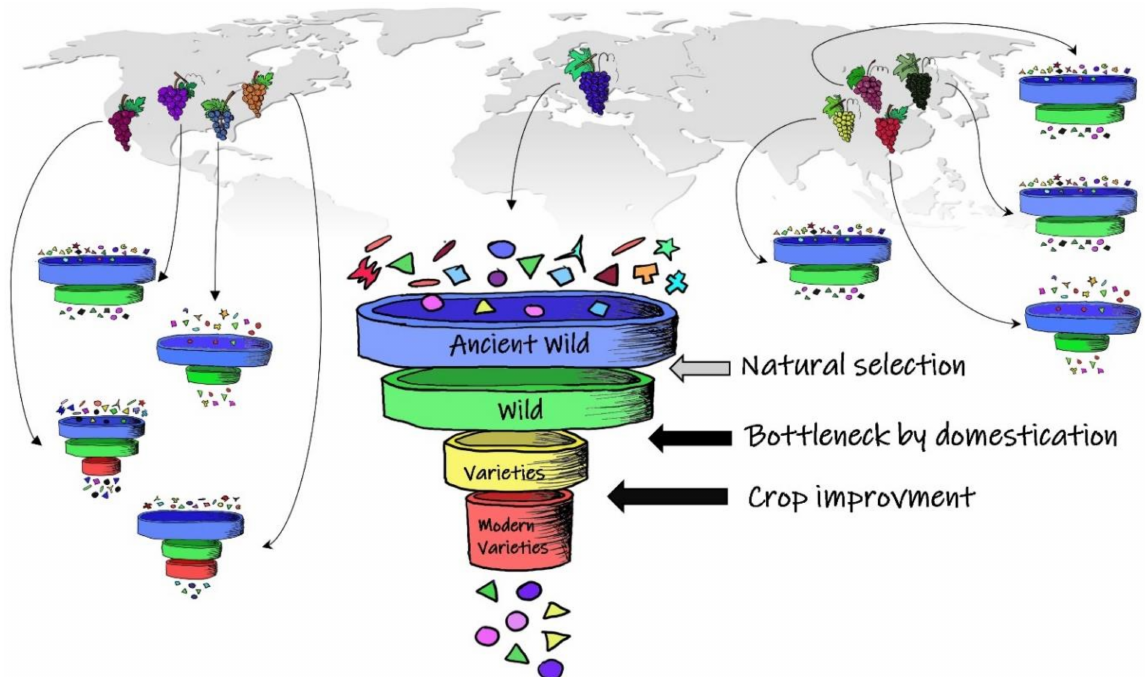
Figure 4. Grapevine is originated from an ancient wild progenitor. Although it has suffered from a weak bottleneck and the breeding have maintained a high level of heterozygosity, several resistance or tolerance genes could be lost during the evolution. The funnel shows the reduction of genetic diversity in time (different shapes indicate different classes of genes and different colours indicate different alleles). Natural selection (horizontal grey arrow) caused by climate changes in the past and artificial selection (horizontal black arrows) caused by human activity more recently can have driven the loss of genes and alleles. On the other hand, the wild American and Asian grapes are adapted to a wide range of climatic conditions and have suffered minor effects from human activity, thus they can harbour several resistance or tolerance genes. The assembly of a pangenome offers the possibility to recover and collect the original gene diversity conserved in wild and domesticated